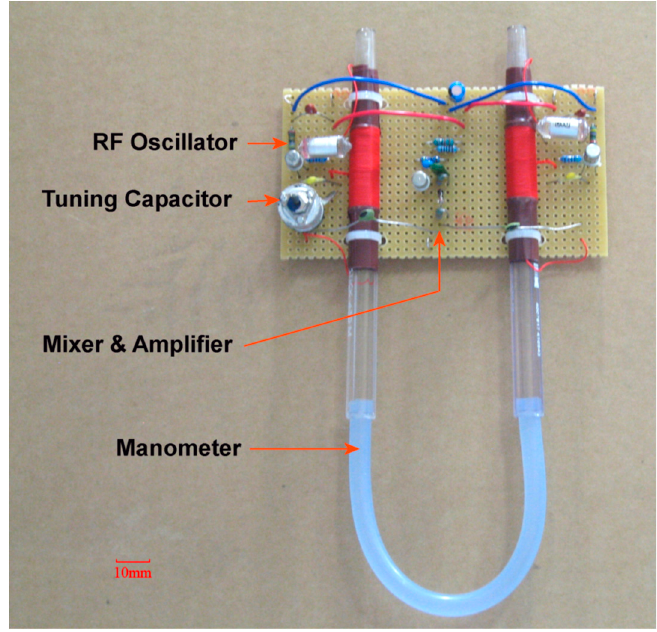
Figure 9. Photograph of the prototype showing, the manometer and beat frequency oscillator.